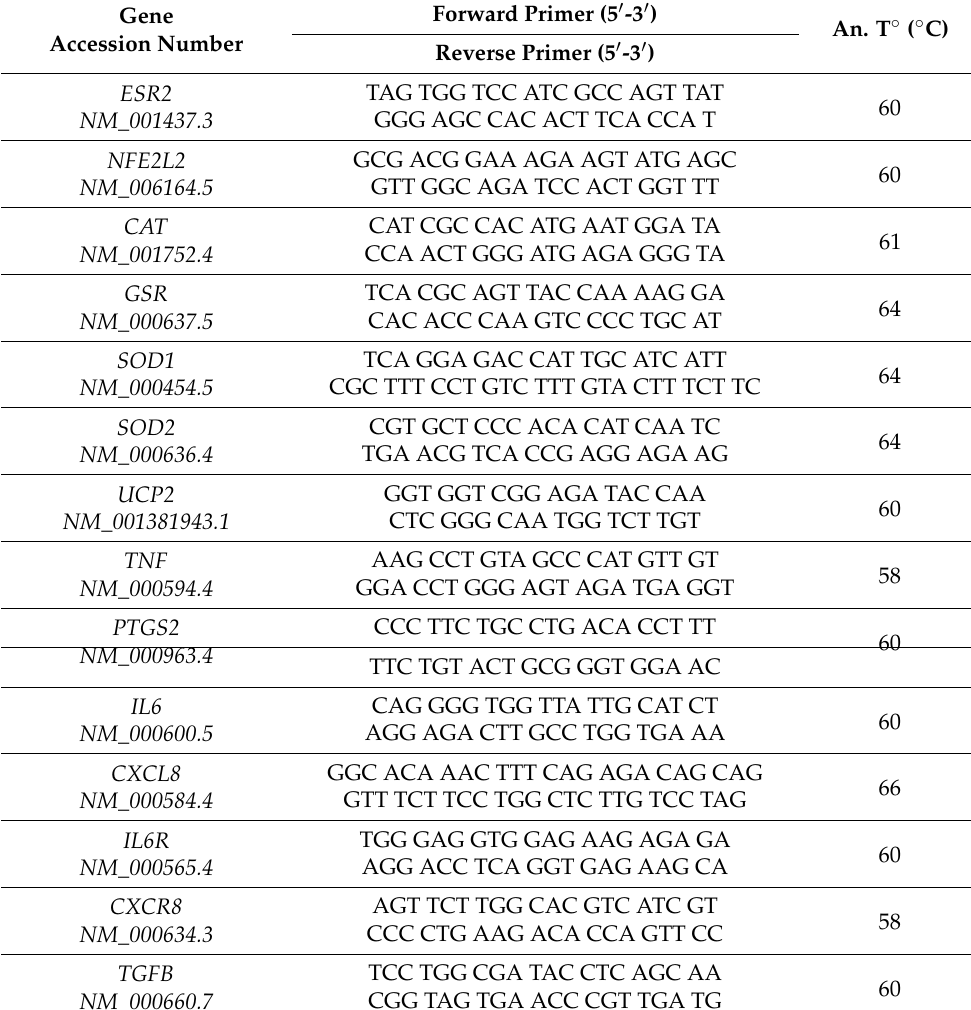
Table 1. Primers and conditions used for